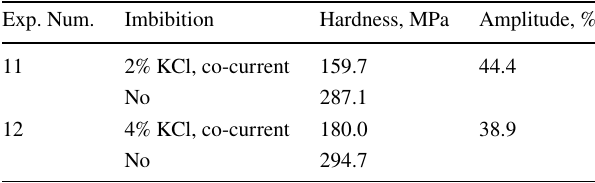
Table 7 Variation of surface hardness before and after imbibition Exp. Num.